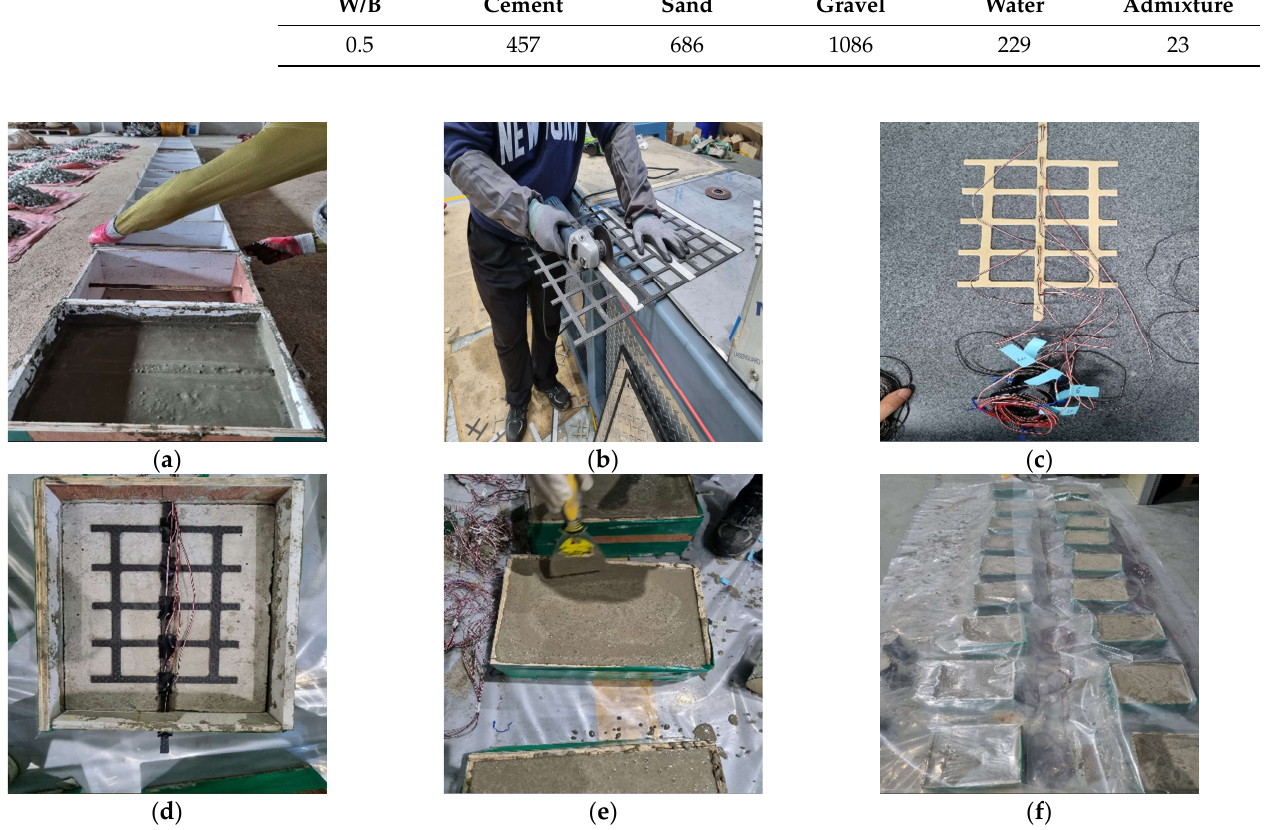
Figure 2. Specimen fabrication of FRP-grid-reinforced concrete with VRHP mortar. ( a ) Concrete casting. ( b ) FRP grid fabrication. ( c ) Installation of strain gauge. (d ) FRP grid installation on. concrete. ( e ) VRHP mortar casting. ( f ) Curing FRP grid reinforced concrete. Table 3. Mix proportion of concrete (kg/m 3 ).